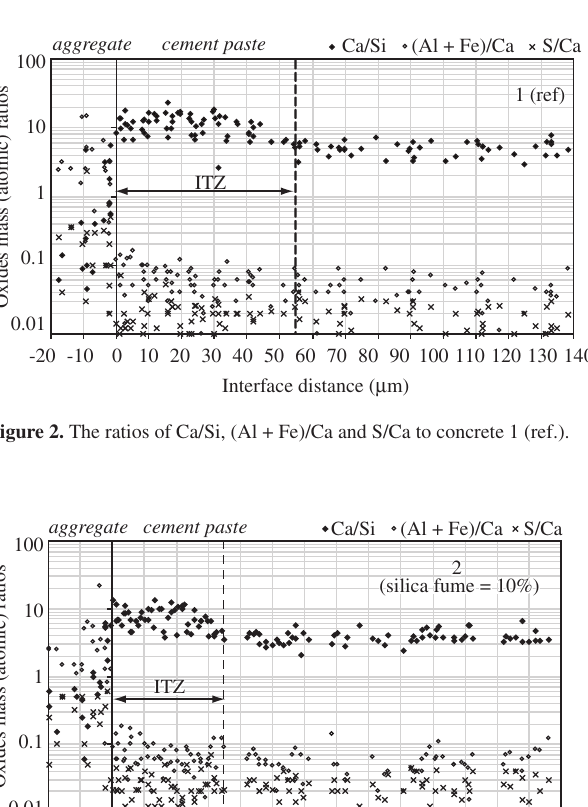
es 6,11,15 for concretes without additions or addictives. Although the most usual values for the thickness of the ITZ are between 40 and 60 µ m in the concrete without additions or addictives, they can vary significantly, due to the type of cement and the water/binder relation